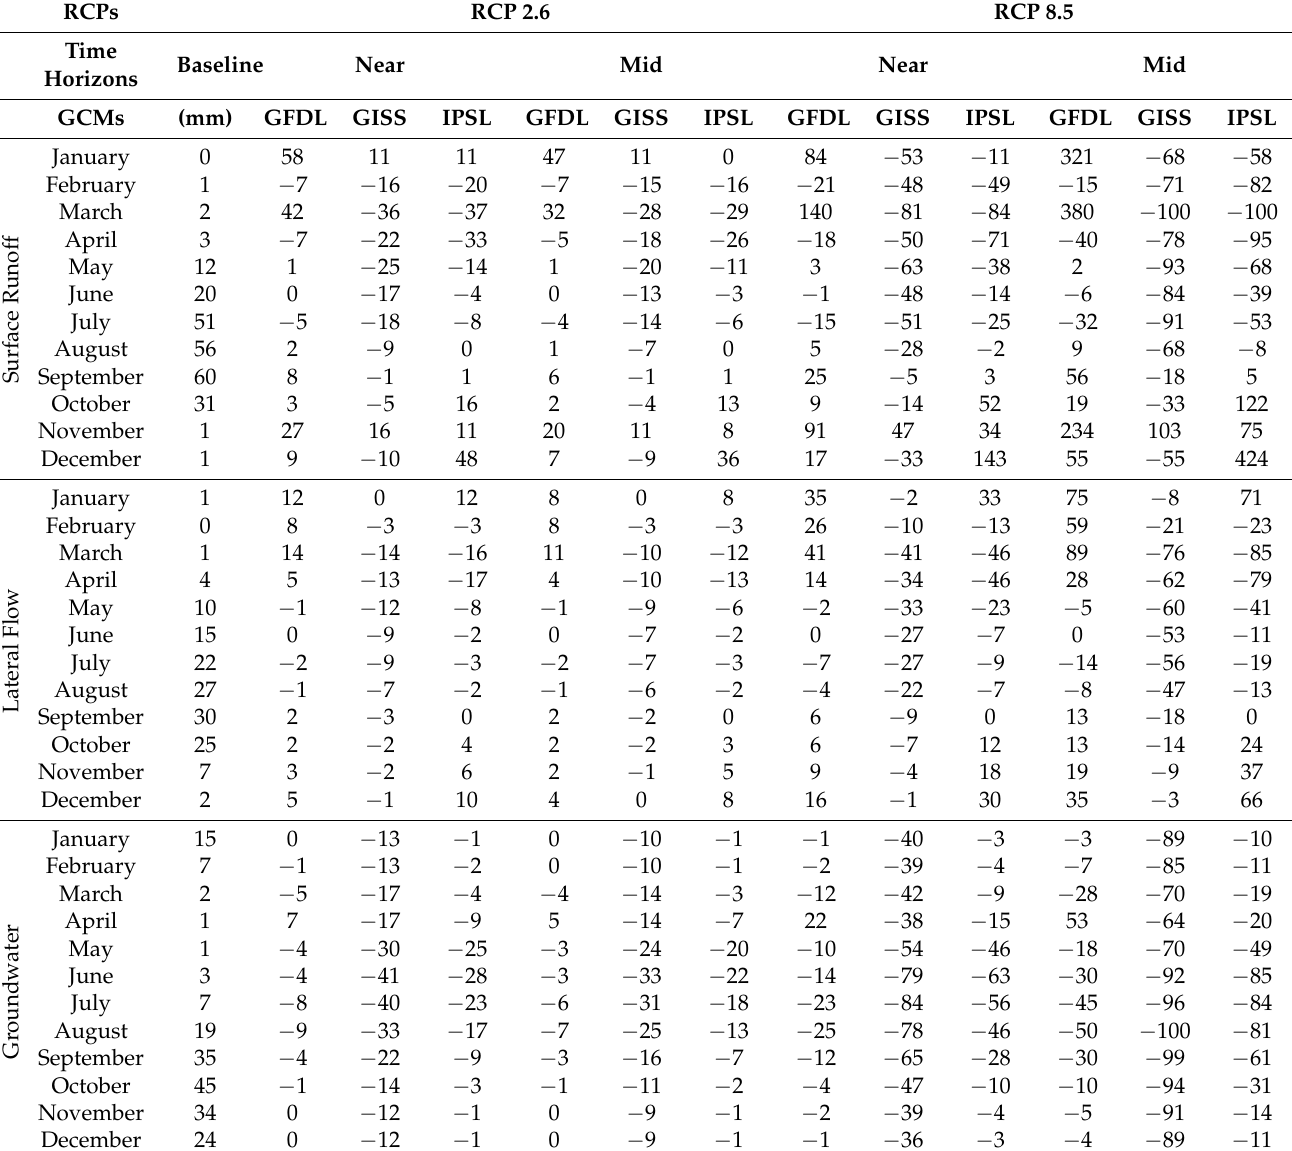
Table 8. Projected mean monthly water yield components and percentage changes in different GCMs compared to the baseline under RCP2.6 and